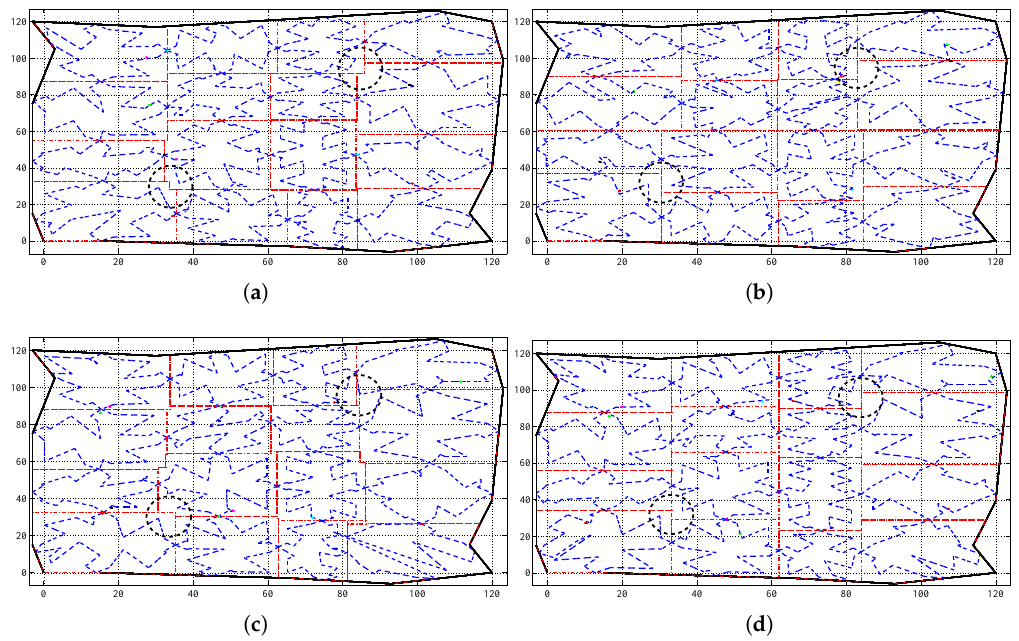
Figure 10. Final area division obtained during the simulation using the coordination algorithms: ( a ) based on the one-to-one coordination, and ( b ) based on the (2,2)-block-sharing strategy. ( c ) based on the column-row decoupling, and ( d ) based on the coordination variables. The dashed red lines determine the final sub-area shapes assigned to the UAVs, the dashed blue lines indicate their coverage paths generated using the path planning method proposed in Acevedo et al. [23] and the thick dashed black circles highlight two examples of the edges of shapes of the computed